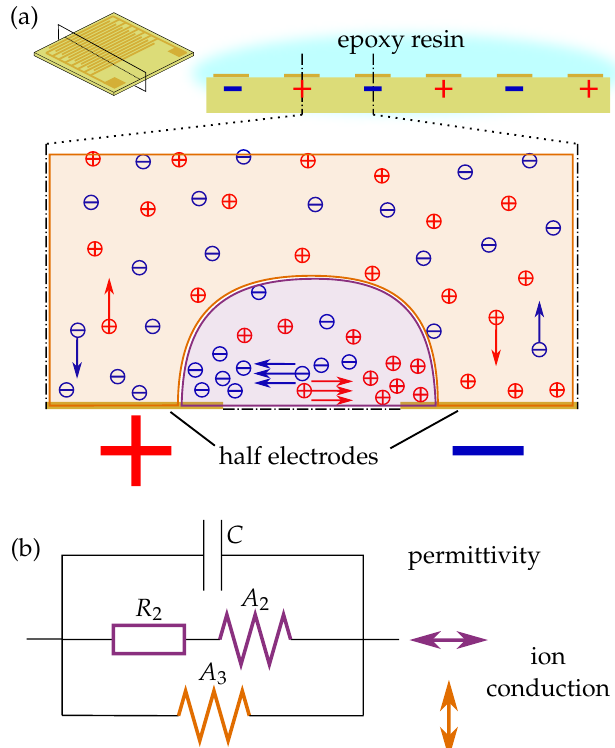
Figure 4. Two-dimensional ion conduction around interdigitated electrodes: ( a ) Illustration of the difference between in-plane conduction and out-of-plane conduction. ( b ) Equivalent circuit for two-dimensional ion conduction and electrode